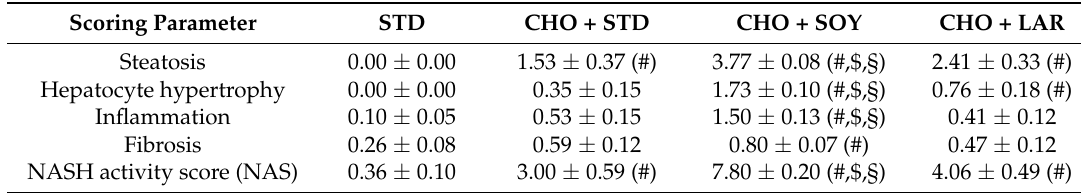
Table 2. NASH activity score grading steatosis, ballooning (hepatocyte hypertrophy), inflammation, and fibrosis. Values are mean ± SEM of 17–35 mice per group. Statistics: Kruskal-Wallis test with Dunn’s post hoc test for multiple comparisons. #: vs. STD, $: vs. CHO + STD, §: vs. CHO + LAD with p <